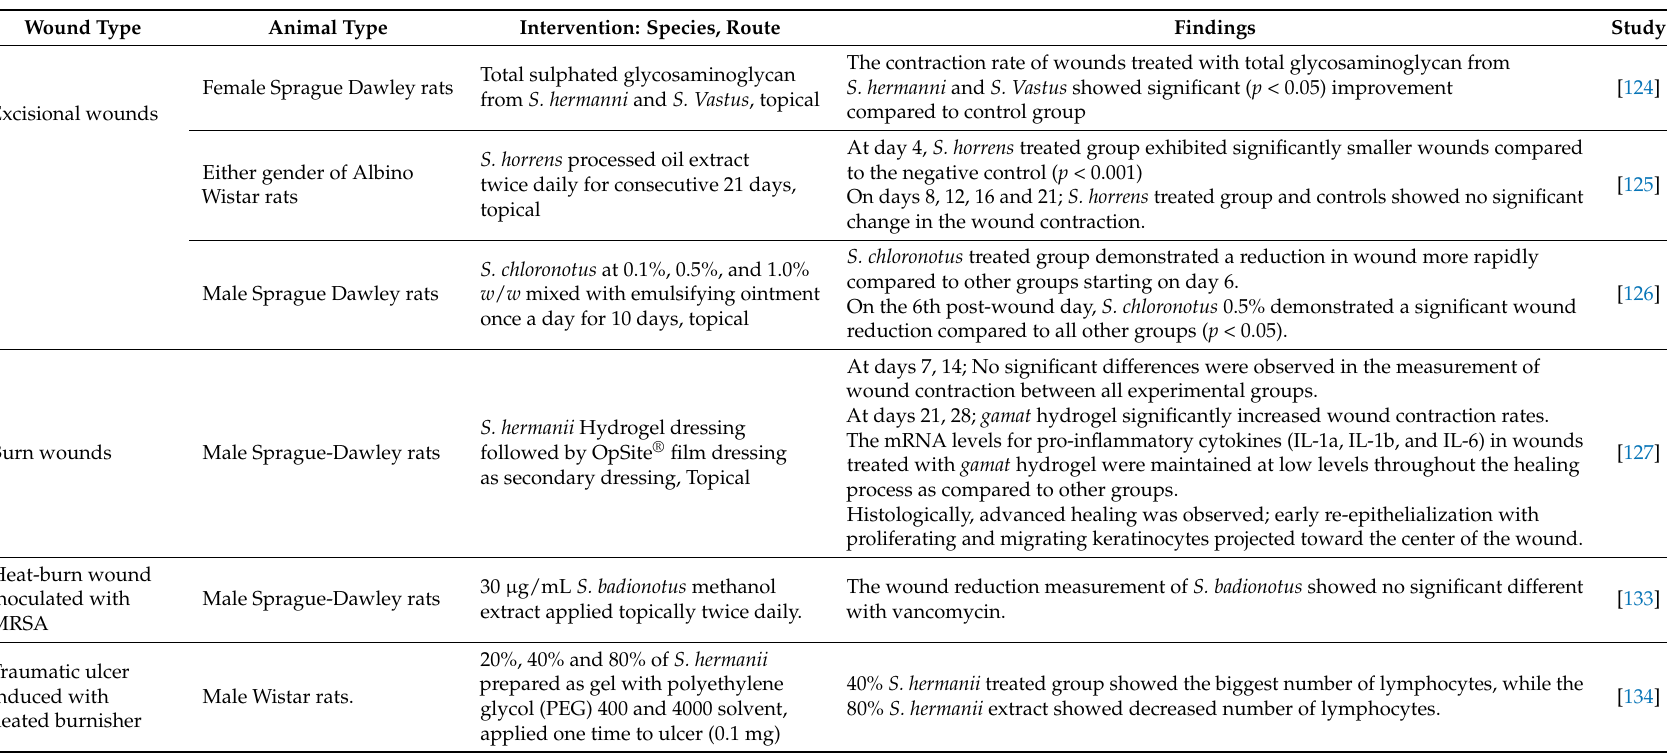
Table 4. The effects of sea cucumber on wound healing in animal